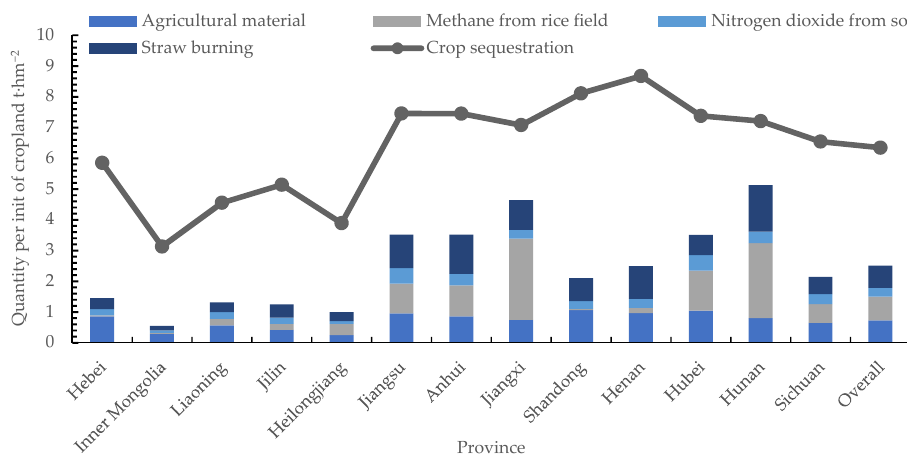
Figure 5. Carbon emissions and sequestration of cropland use in the Chinese principal grain-producing provinces from 2000 to 2019.